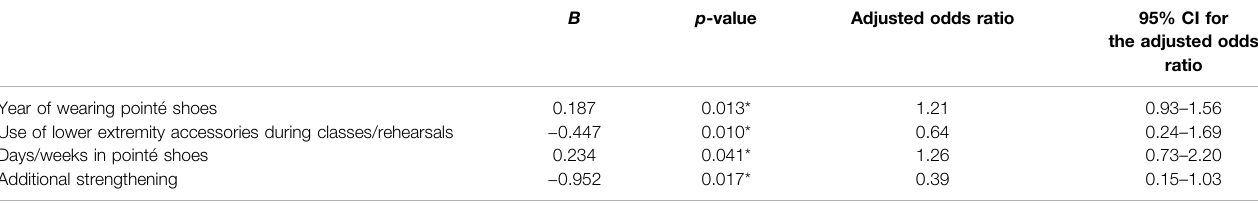
TABLE 3 | Signi fi cant predictors to lower extremity injury in ballet dancers.